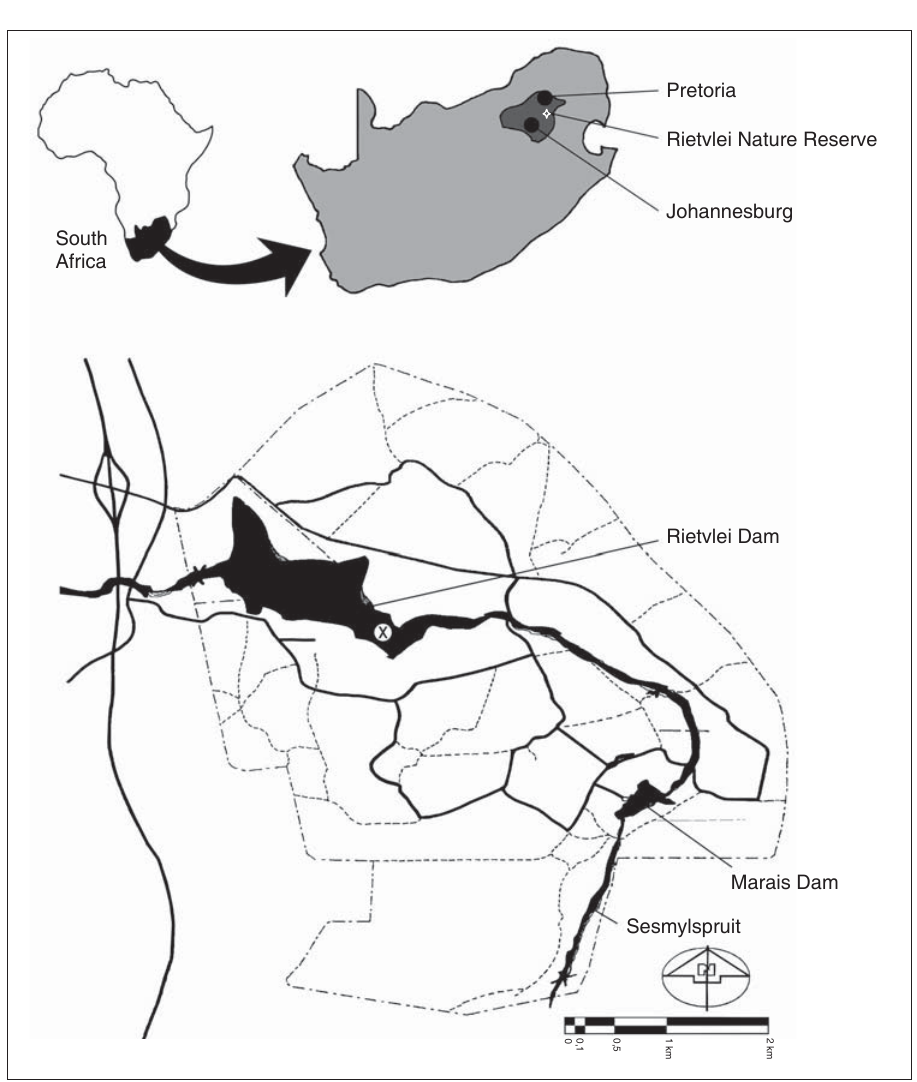
FIG. 1 The location of the Rietvlei Dam inside the Rietvlei Nature Reserve. X indicates point of